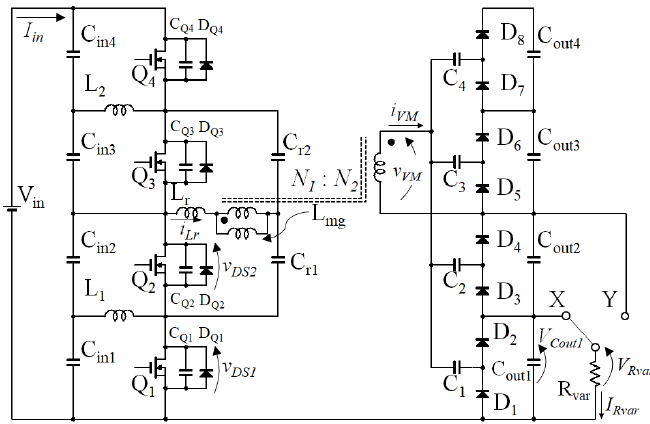
Figure 12. Experimental setup for characteristic measurement.